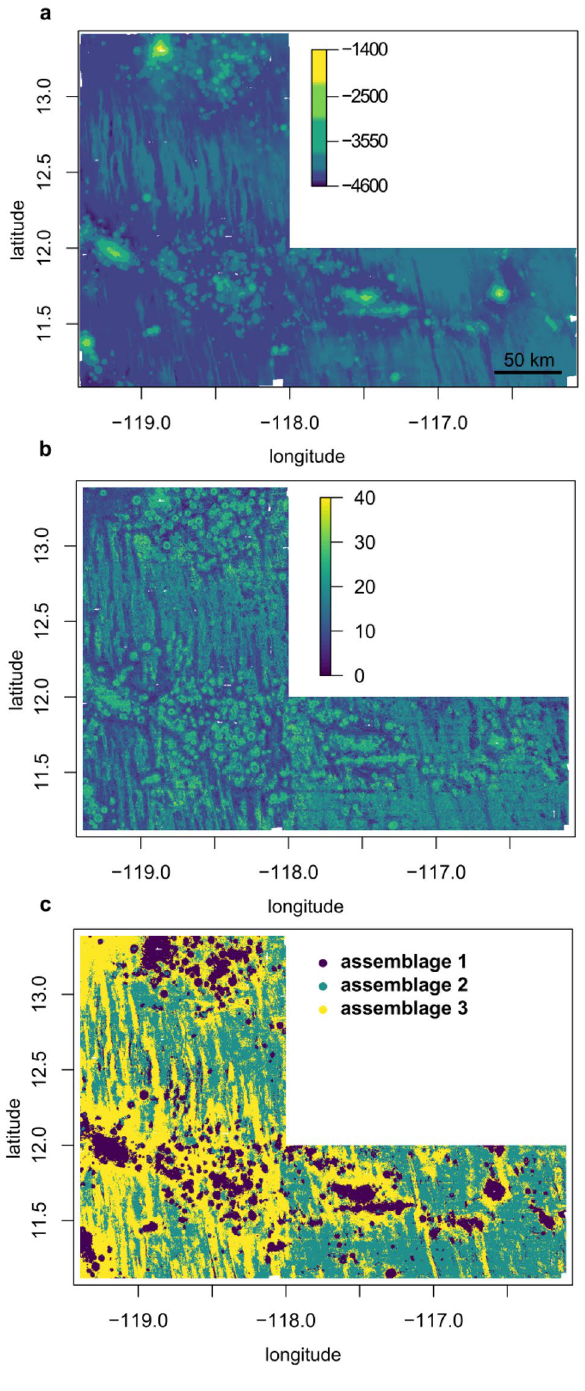
Figure 1. Map of the study area showing water depth ( a ), morphotype richness as the summarized number of morphotypes with a predicted probability of more than 0.5 at each position ( b ), and the megafauna assemblages computed with k-means clustering based on the predicted probability of occurrence of the megafauna morphotypes ( c